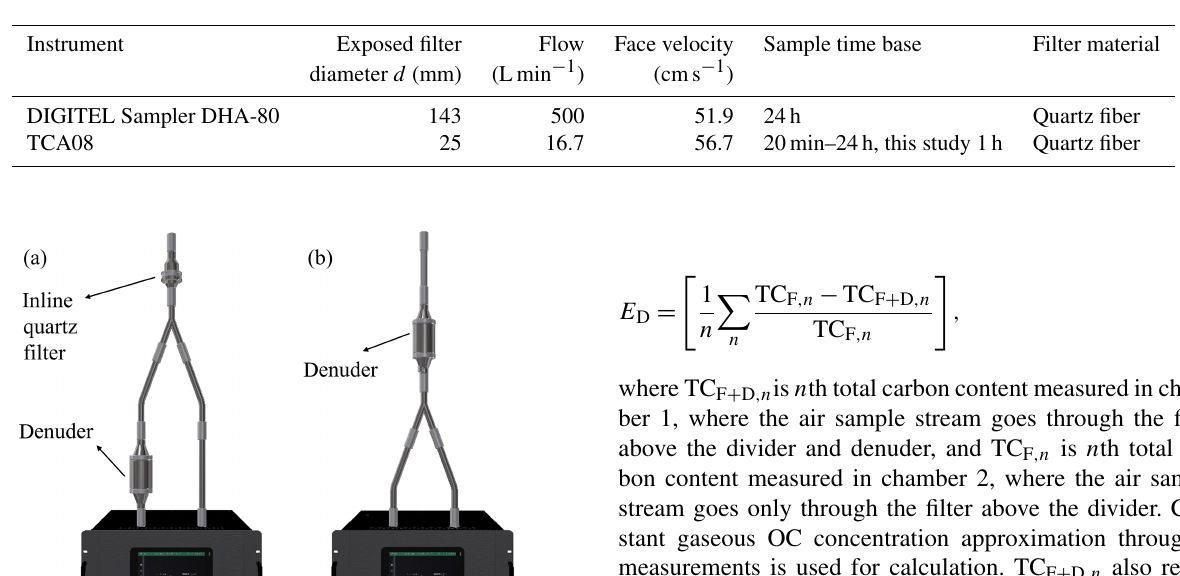
Table 1. Filter collection area diameter, sample flow rate, face velocity, sample time base and filter material for the filter-based instruments used for the OC–EC concentration measurements.